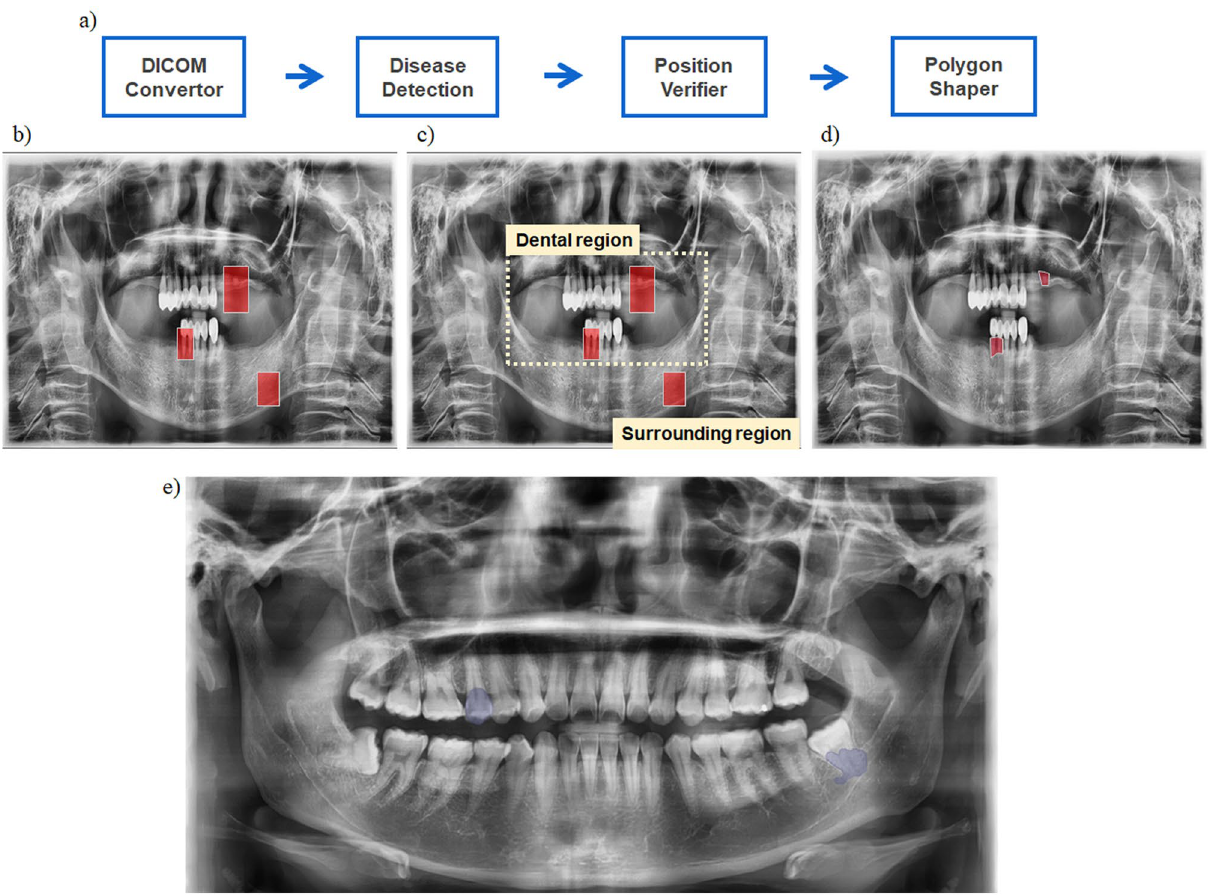
Figure 2. Anomaly detection process of our model. (a) Overall process of this model, (b) result of disease detection stage. Boxes are found from the faster R-CNN architecture. (c) Example of position verifier, carious lesion, for example, is known to be located in dental region, so boxes which are located in surrounding region are deleted. (d) Result of polygon shaper. To notice dental clinicians why the regions are detected to be abnormal, this model narrows down the region into polygon shape. (e) Example figure of final outcome of the model. Proximal caries in upper tooth is in asymptomatic stage but this model can find this. This